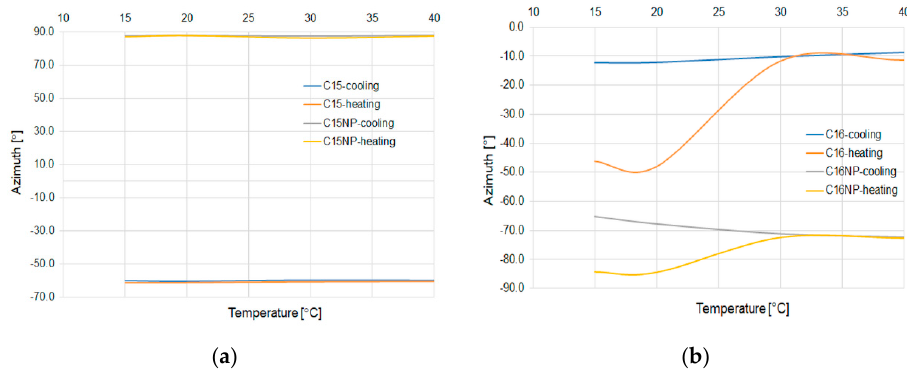
Figure 14. Change of level of azimuth for different temperatures for all kinds of microdevices for pure materials and with NP mixtures C15 ( a ) and C16 ( b ).